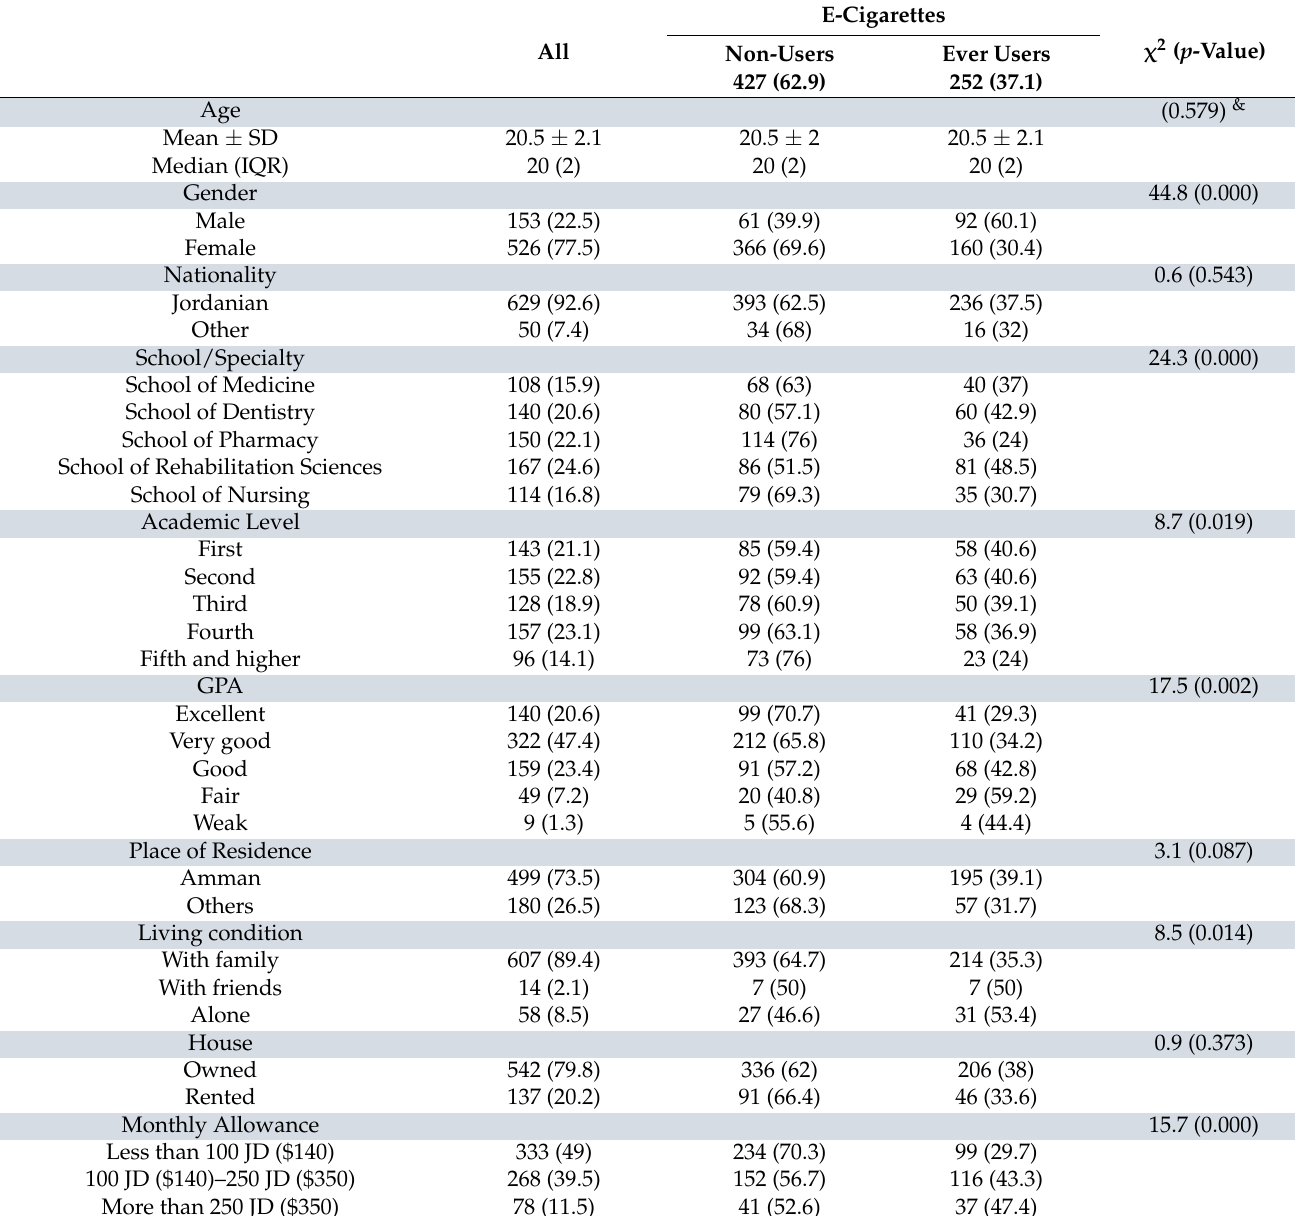
Table 1. Study Participants’ Demographics, N =